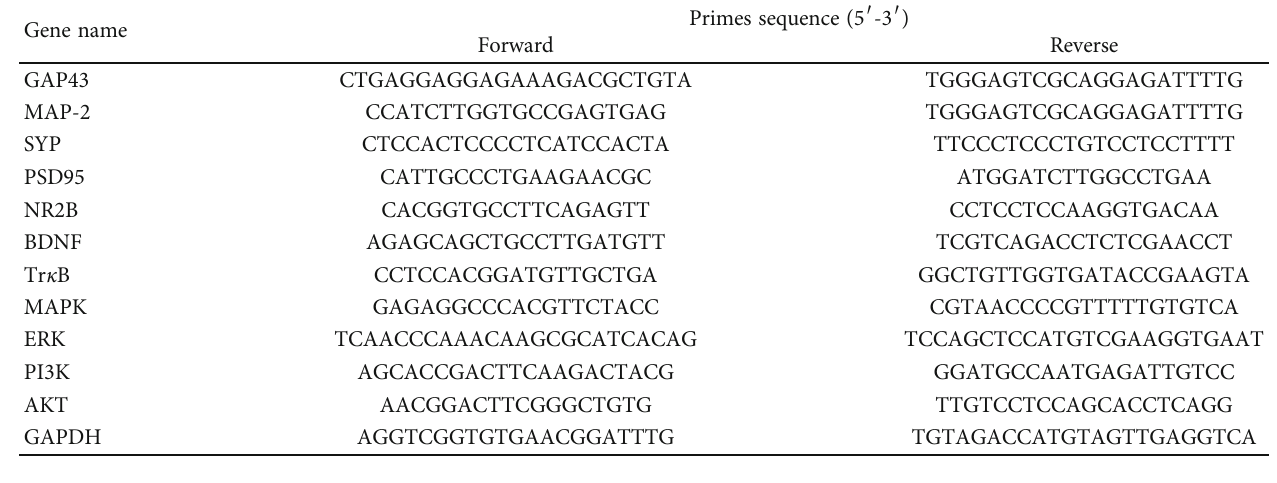
Table 1: Primer sequences of qPCR.